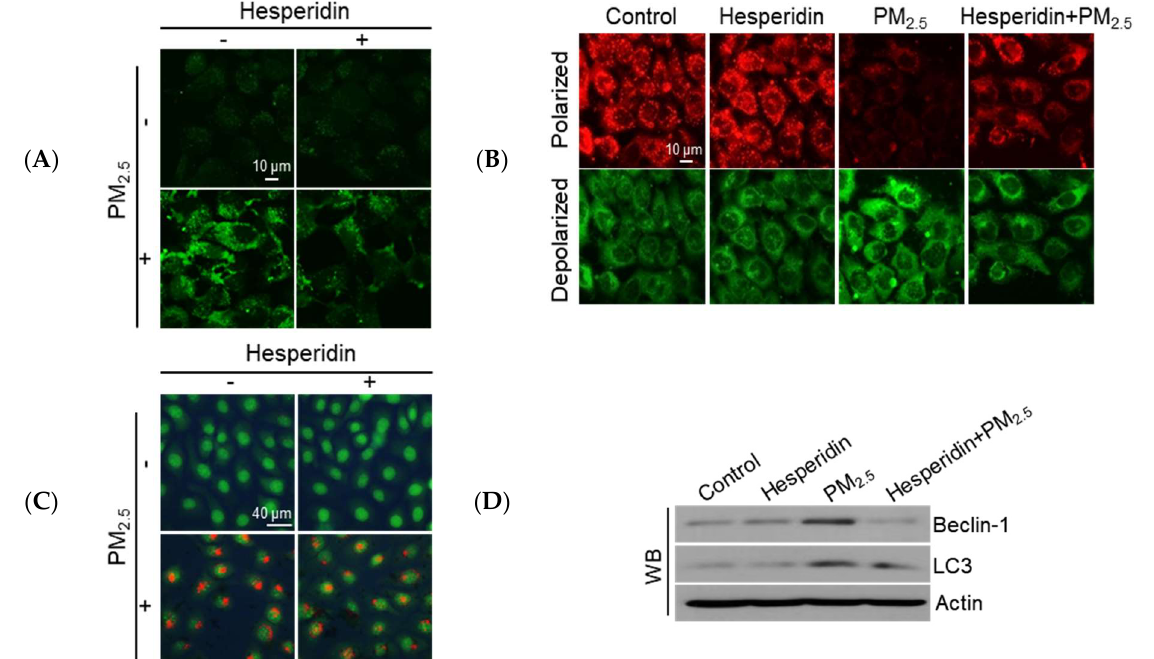
Figure 3. Hesperidin prevented PM 2.5 -induced intracellular Ca 2+ accumulation, mitochondria dys- function, and autophagy. Cells were pretreated with hesperidin (50 µM) for 1 h, and then exposed to PM 2.5 (50 µg/mL) for another 24 h. ( A ) Intracellular Ca 2+ level was detected using confocal micros- copy after Fluo-4-AM staining. ( B ) The mitochondrial membrane potential was detected using con- focal microscopy after JC-1 staining. ( C ) Autophagy was detected using fluorescence microscopy after acridine orange staining. ( D ) Cell lysates were subjected to western blotting of target proteins (beclin-1, LC3, and actin).